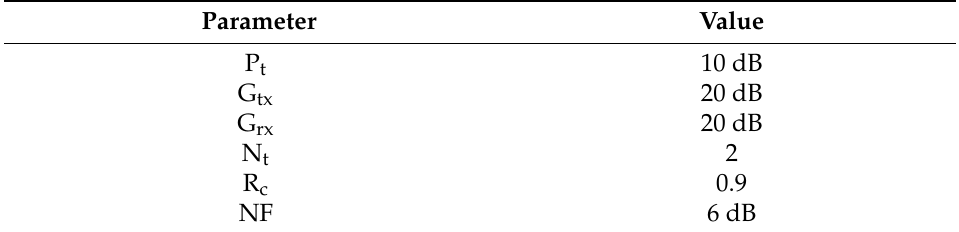
Table 3. SNR simulation